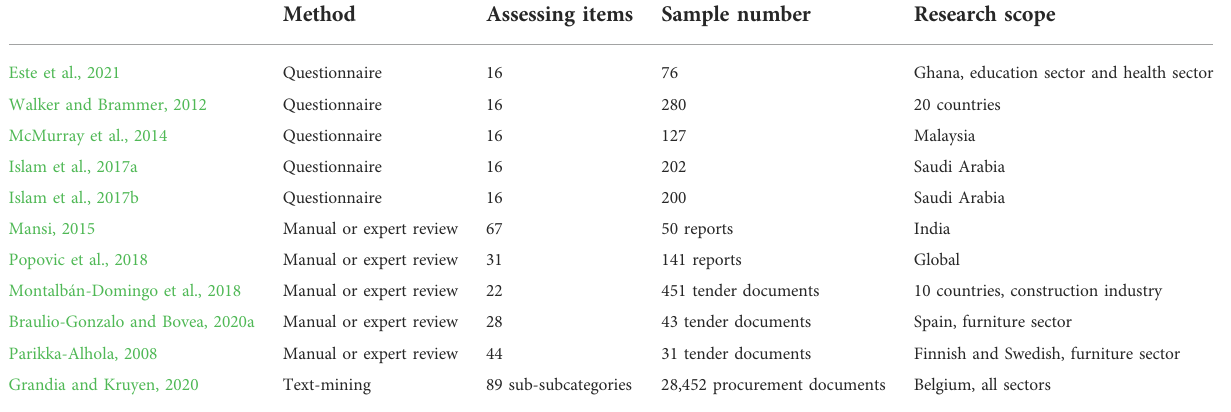
TABLE 1 Methods and scopes compared of the SPP